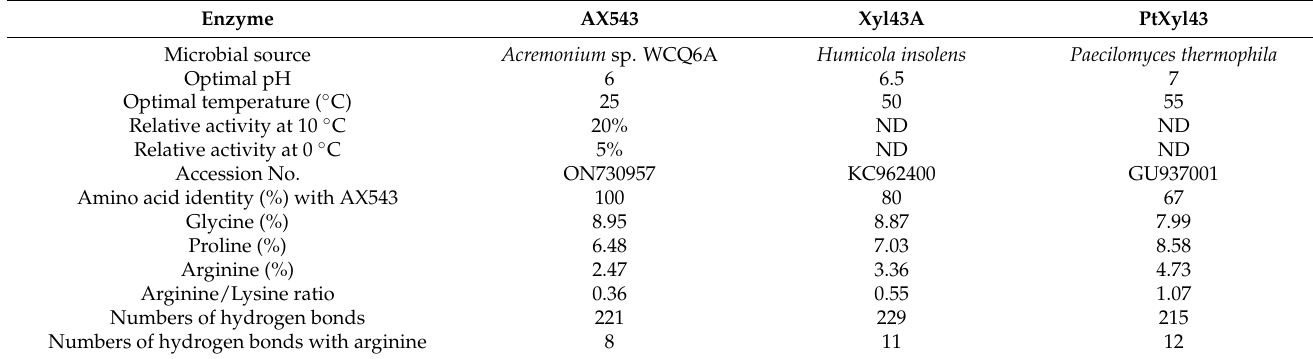
Table 2. Comparison of amino acid composition and hydrogen bonds of psychrophilic xylosidase AX543 and its thermophilic counterparts Xyl43A and